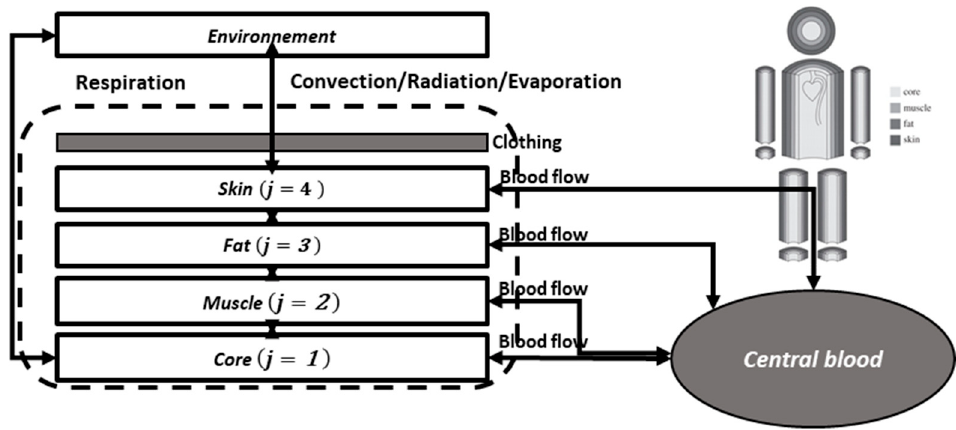
Figure 5. Conceptual figure of Tanabe model [2].